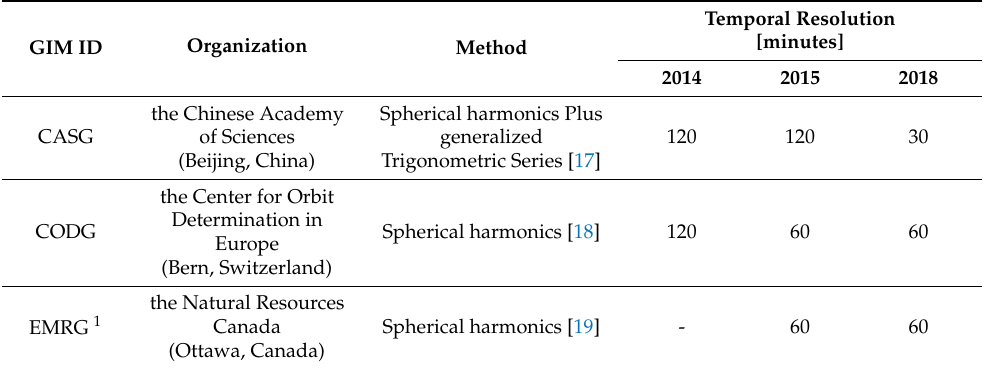
Table 1. Summary of the global ionosphere maps (GIMs) assessed in this